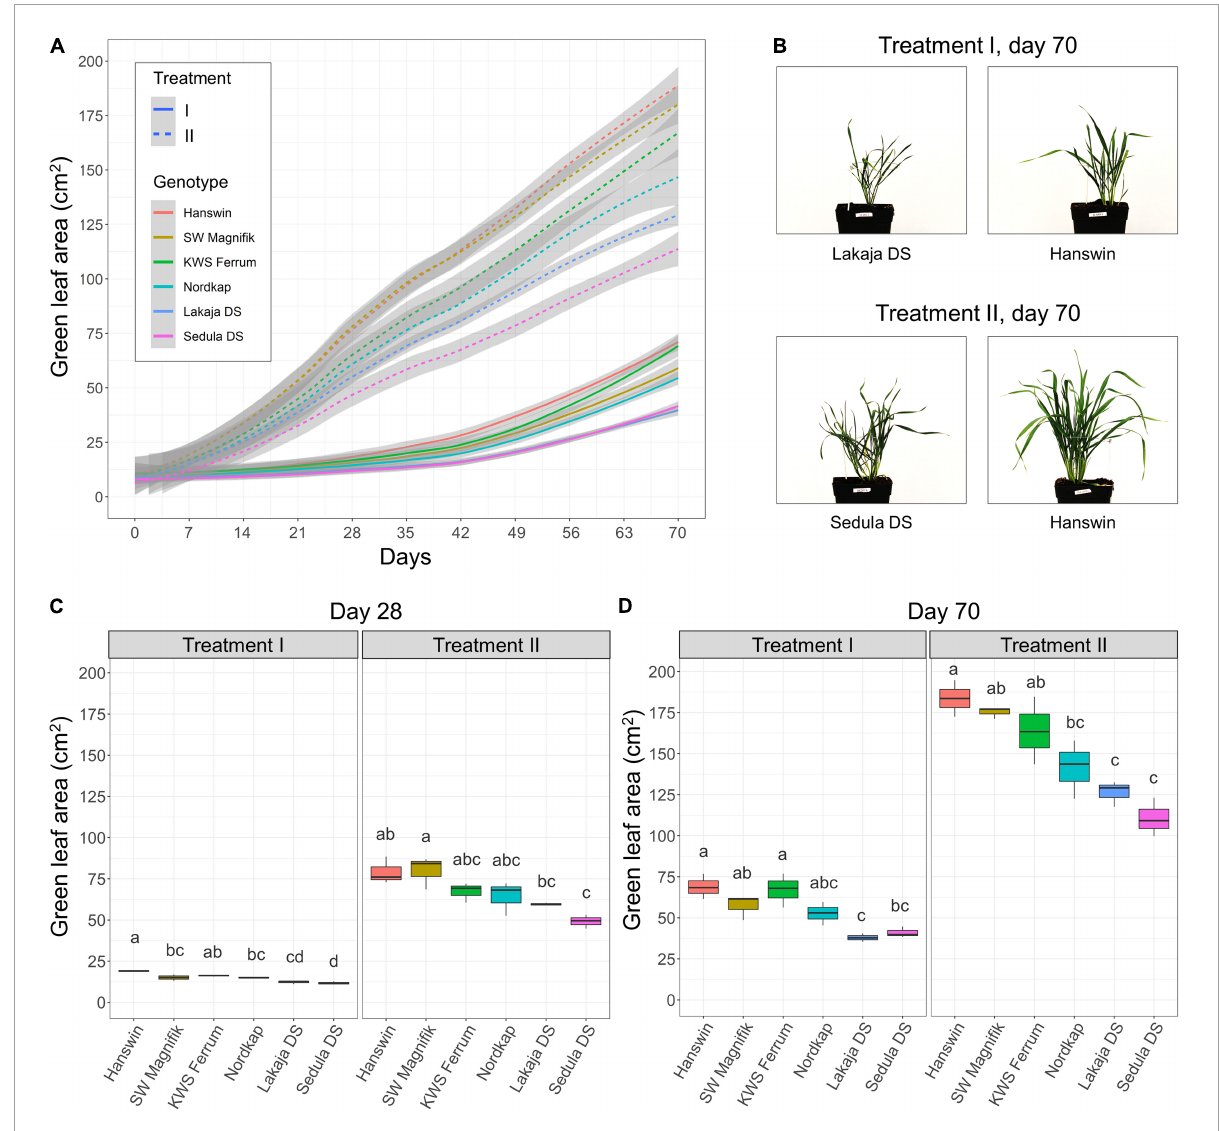
FIGURE2 The effect of different low-temperature regimes during CA on shoot biomass accumulation of winter wheat. Dynamics of shoot biomass accumulation of 6 winter wheat genotypes during 49 days of CA, followed by 7 days of DEA and 14 days of REA in two low-temperature treatment groups. In treatment I, the plants were subjected to constant CA at 2 ◦ C for 49 days, while in treatment II the plants went through CA at 10 ◦ C for 28 days, followed by 2 ◦ C for 21 days. The gray areas indicate the 95% confidence interval (A) . Side-view images of the wheat genotypes, displaying least and most shoot biomass growth, subjected to treatments I and II, on day 70 (B) . Shoot biomass of 6 winter wheat genotypes on day 28 (C) and day 70 (D) in treatments I and II. The letters above the boxplots indicate significant ( p < 0.05) differences between genotypes within each treatment